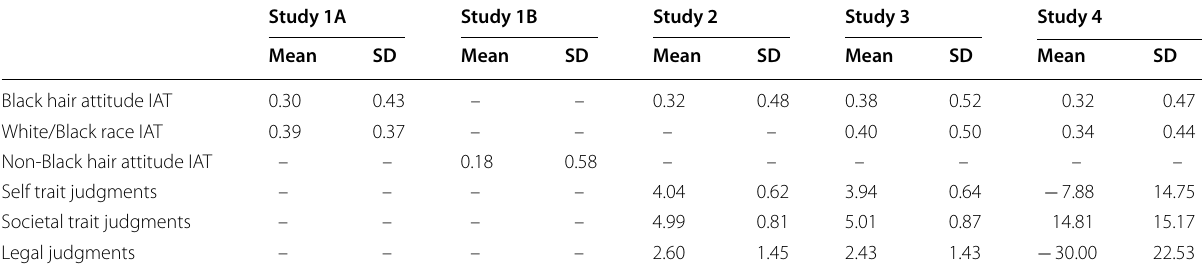
Implicit Association Tests (IATs), self trait judgments, and legal judgments were scored such that higher scores indicate higher levels of race bias against Afrocentric hair texture and/or African American targets. Societal trait judgments were scored such that higher scores indicate higher levels of awareness of societal bias. The theoretical range of IAT scores was [ 2; 2], whereas the theoretical range of the explicit judgments was [1; 7] in Studies 1–3 and [ −